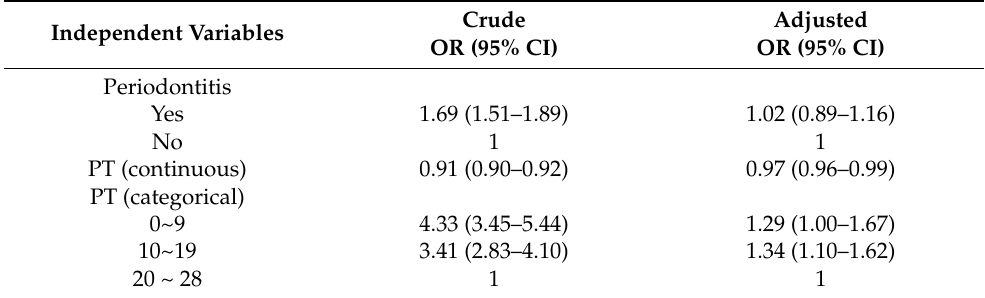
Table 3. Multivariate logistic regression analysis of oral health status and relative handgrip strength. Crude Adjusted Independent Variables OR (95% CI) OR (95% CI) Periodontitis Yes 1.69 (1.51–1.89) 1.02 (0.89–1.16) No 1 1 PT (continuous) 0.91 (0.90–0.92) 0.97 (0.96–0.99) PT (categorical) 0~9 4.33 (3.45–5.44) 1.29 (1.00–1.67) 10~19 3.41 (2.83–4.10) 1.34 (1.10–1.62) 20 ~ 28 1 1 OR: odds ratio, 95% CI: 95% confidence interval. Adjusted for general characteristics (gender, age, educational level, and household income), general health behaviors (smoking, alcohol consumption, exercise, and